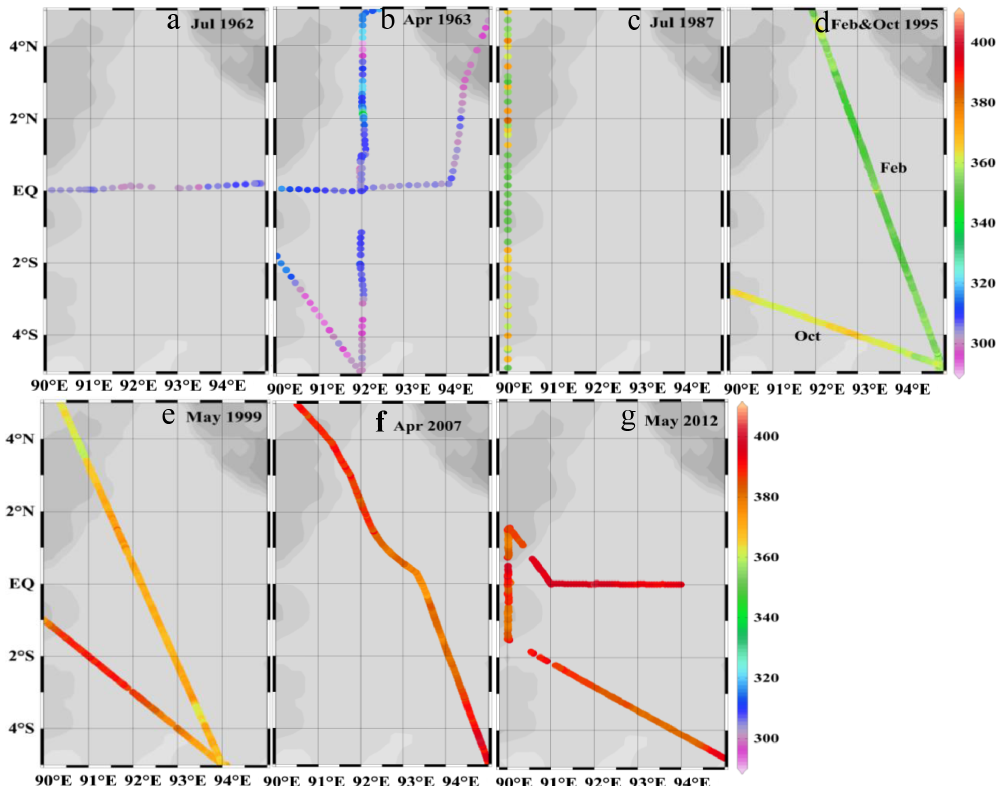
Figure 3. Sea surface CO 2 partial pressure ( p CO 2 ) observed in July 1962 (a) , April 1963 (b) , July 1987 (c) , February and October 1995 (d) , May 1999 (e) , April 2007 (f) , and May 2012 (g) in the EIO. This figure is plotted with ODV software (Schlitzer, 2014). Table 3. Sea surface p CO 2 trend observed in various regions of the ocean. Region Period p CO 2 growth Sink/source a Reference rate (µatmyr − 1